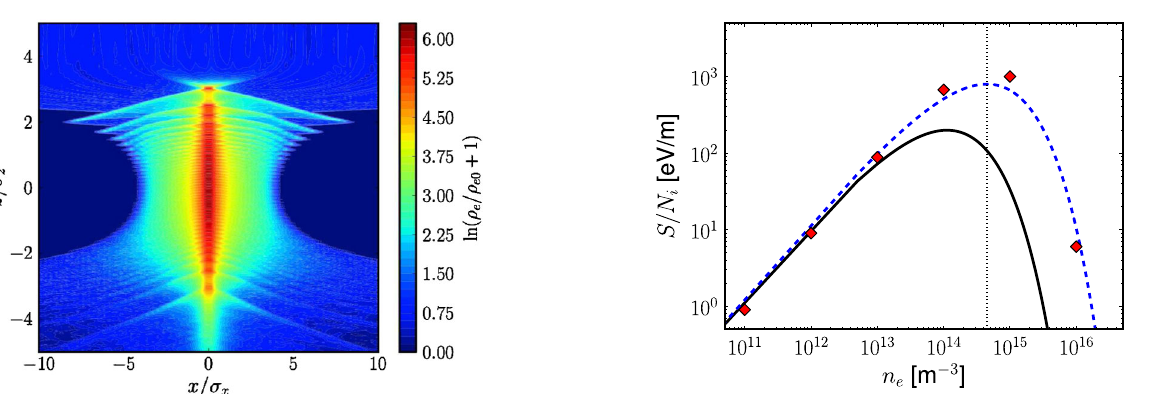
¼ en n ¼ e , with e 0